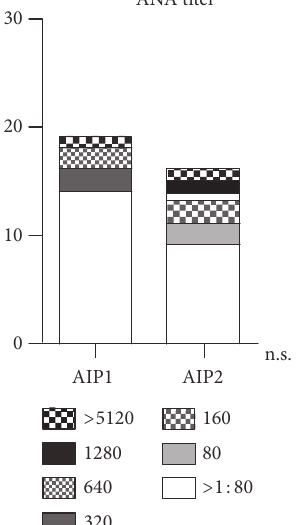
Figure 5: Patients with AIP1 and AIP2 revealed increased ANA